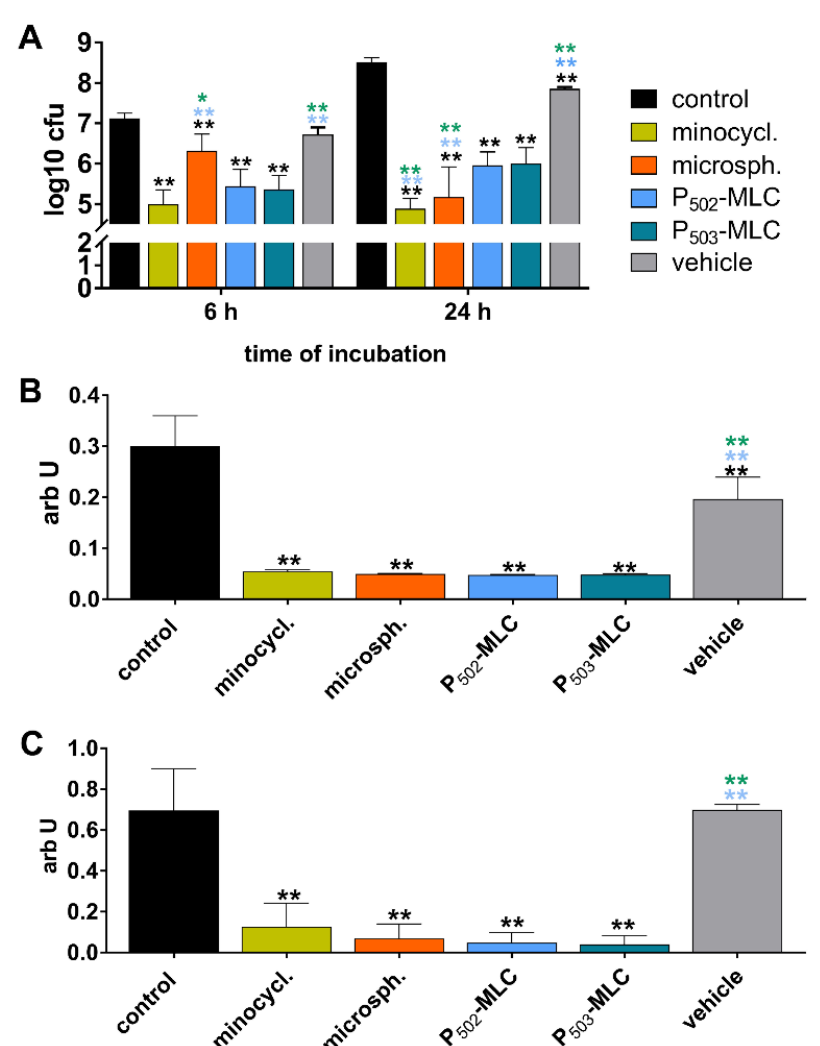
Figure 2. Activity of the minocycline formulations (substance (minocycl.) and microspheres (microsph.) polymer-lipid complex extrudate (PLM-C)) and PLM-C without minocycline (vehicle) on formation of a six-species biofilm. Bacterial counts determined as colony forming units (CFU) ( A ); biofilm quantity ( B ); and metabolic activity ( C ). ** (black) p < 0.01 vs. control; ** (blue) p < 0.01 vs. P 502 -MLC; * (green) p < 0.05 / ** (green) p < 0.01 vs. P 503 -MLC.